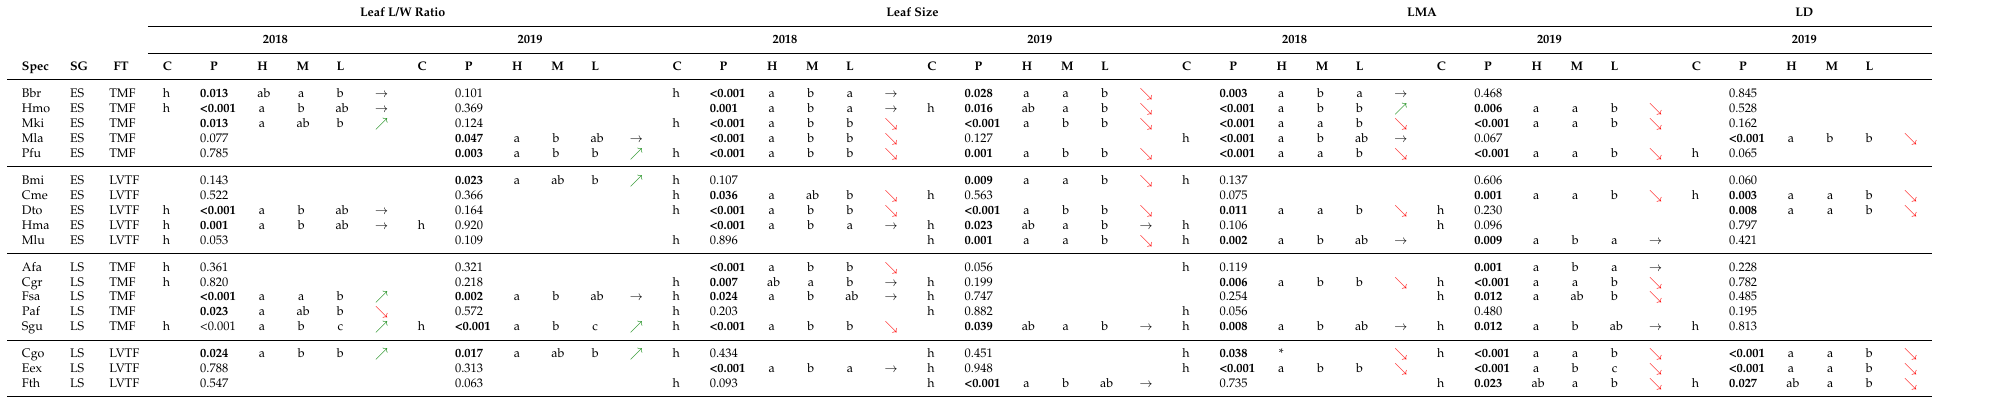
Table 3. Significance of warming effect on leaf shape (width-to-length ratio, W/L) leaf size (leaf area) and leaf mass per unit area (LMA) in 2018 and 2019, and on leaf volume per unit area (LVA) and leaf density (LD) in 2019. Different letters (a, b, c) denote significant differences between sites. H, M and L represent high- (Sigira), mid- (Rubona) and low- (Makera) elevation sites, respectively. Explanation of species codes is given in Table 2; SG, successional group (ES, early; LS, late); FT, forest type (TMF, tropical montane forest; LVTF, Lake Victoria transitional forest); C, covariate used in statistical analysis when significant; h, tree height. The arrows indicate the direction of warming effect of species with significant site effect ( p <